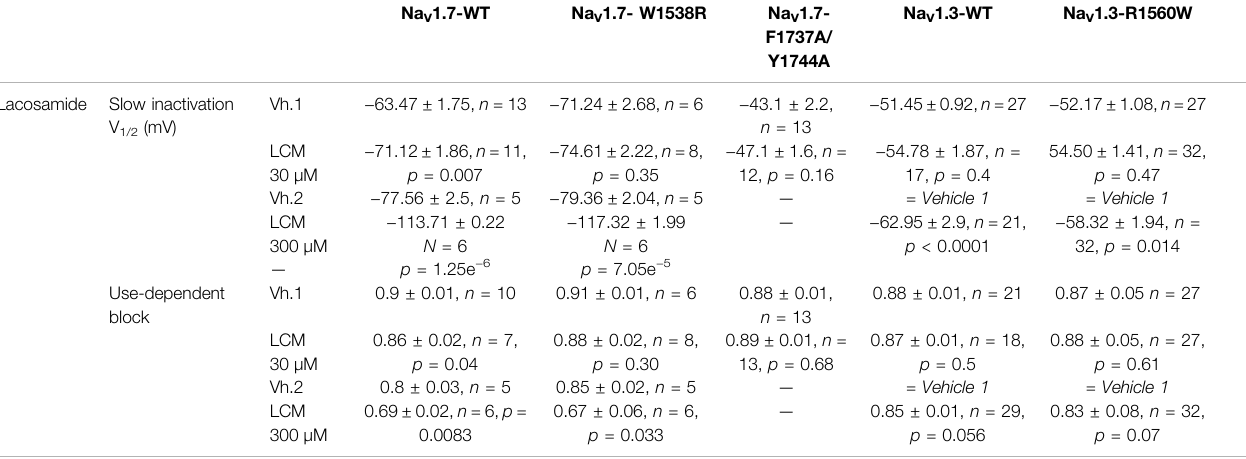
TABLE 1 | Effects of lacosamide (LCM) at the clinically-achievable concentration of 30 μ M and at 300 μ M on NaV1.7 and NaV1.3 wild-type and mutant channels. Lacosamide signi fi cantly enhanced slow inactivation and use-dependence of inhibition in Na V 1.7-WT channels at both 30 and 300 μ M compared to vehicle, Vh.1 for 30 μ M and Vh.2 for 300 μ M (Vehicle; extracellular solution), as per different recording days for manual patch clamp analysis. Clinically-achievable concentrations (30 μ M) of lacosamide had no effect on any of the mutant channels (ie. Na V 1.7-W1538R, Na V 1.7-F1737A/Y1744A and Na V 1.3-R1560W) or Na V 1.3-WT channels. However, at the higherdoseof300 μ M,lacosamideevokedasigni fi canthyperpolarizingshiftinslowinactivationofNa V 1.3-WT,Na V 1.3-R1560WandNa V 1.7-W1538Rmutantchannels.